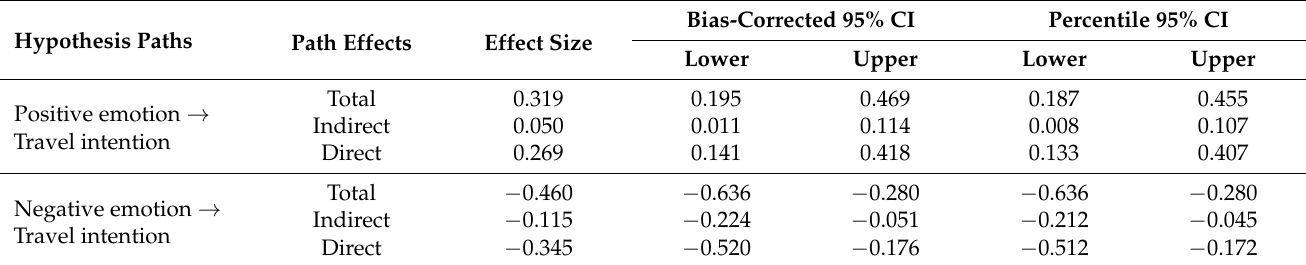
Table 5. Results of mediation effect analysis.